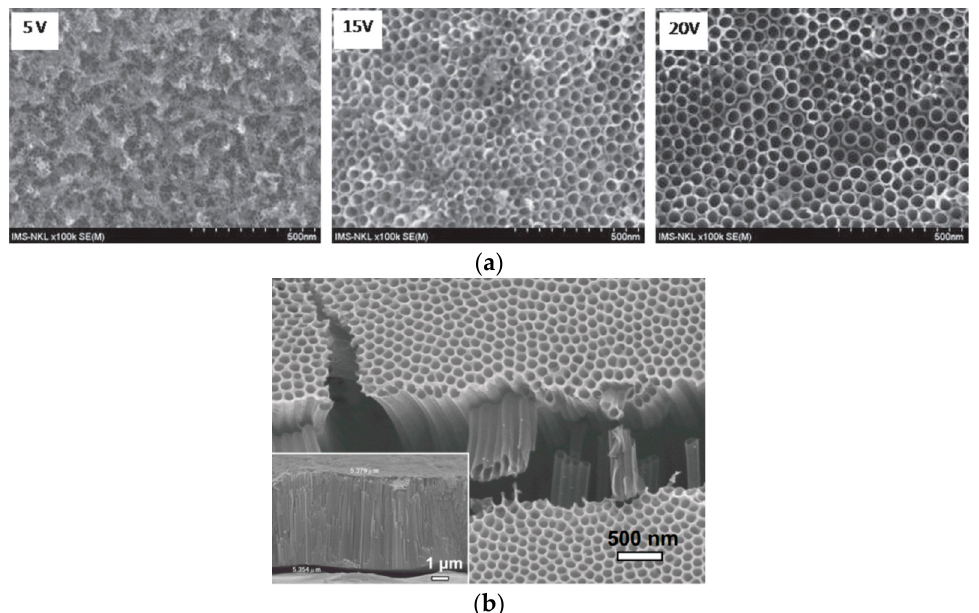
Figure 13. ( a ) Top-view scanning electron micrographs of TNT arrays prepared by anodizing Ti in a mixed ethylene glycol/NH 4 F and water solution under applied voltages of 5, 15 and 20 V for 5 h. Reproduced with permission from [225]. Copyright IOP Publishing, 2014. ( b ) Cross-sectional SEM image (inset) and top view of TNTs fabricated by anodizing Ti in a mixed ethylene glycol/NH 4 F and water solution at 30 V for 1 h. Reproduced with permission from [223]. Copyright MDPI, 2019.